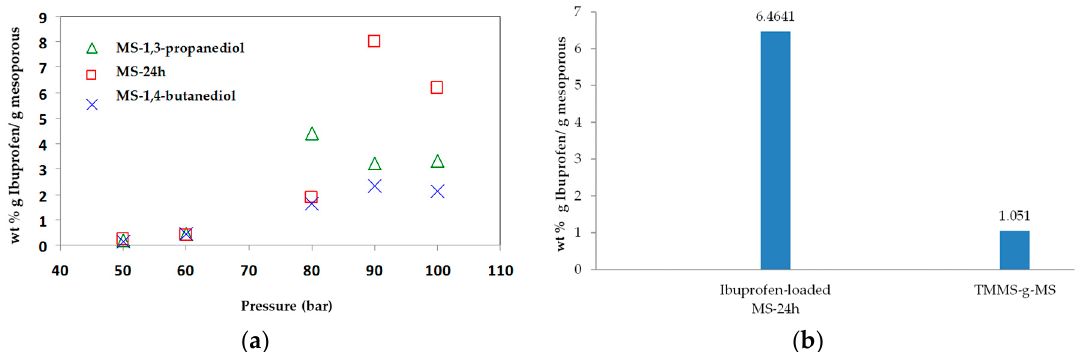
Figure 7. Concentration of ( a ) wt % ibuprofen loaded mesoporous silicas with different pressure at 40 °C and ( b ) ibuprofen-loaded MS-24h and TMMS-g-MS at 90 bar, 40 °C where the equilibrium concentration of Ibuprofen in CO 2 was 0.0740 wt %.